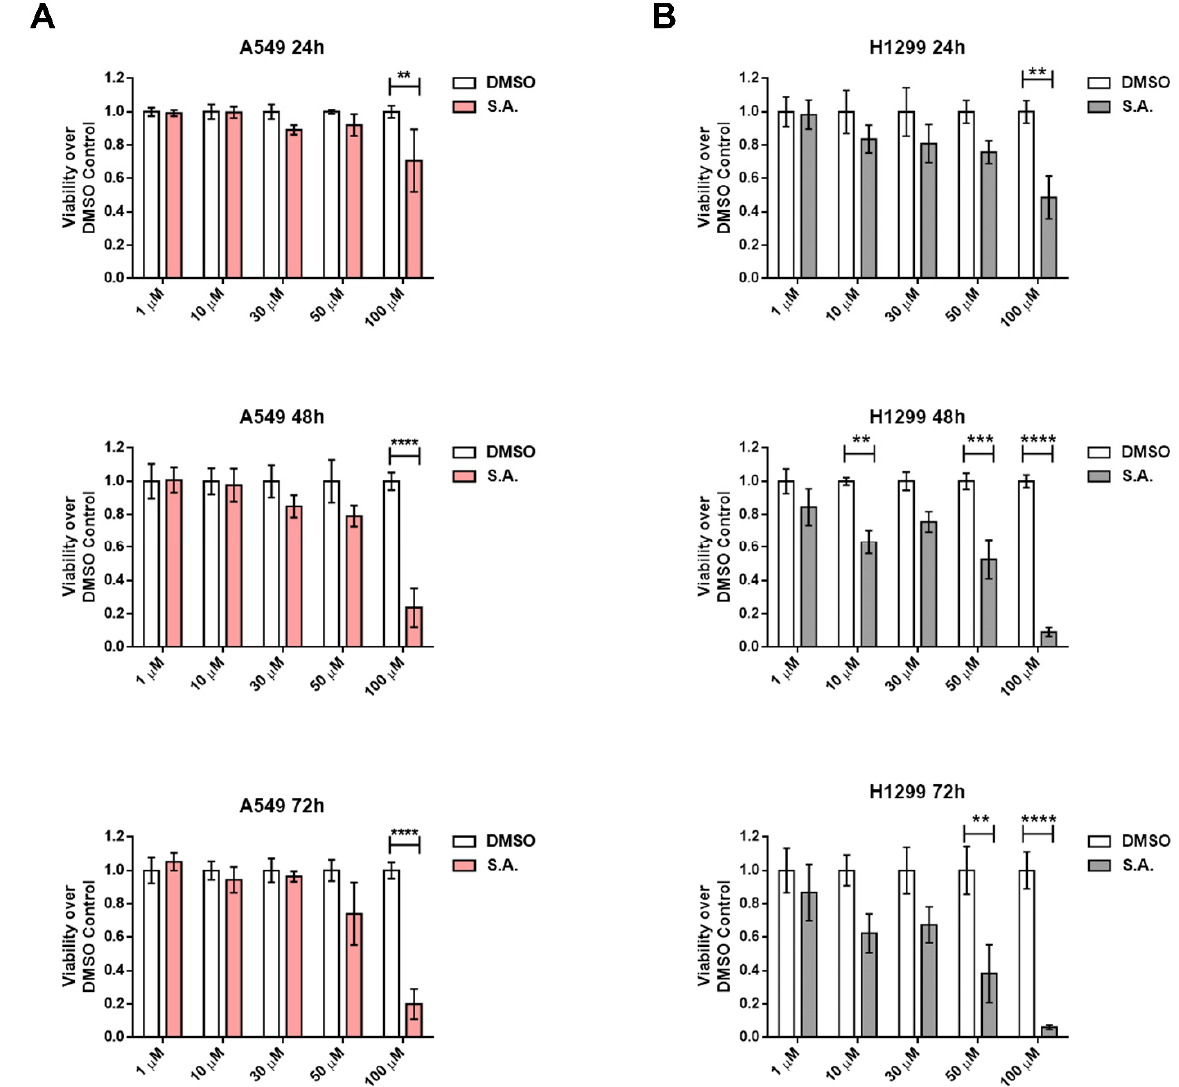
Figure 2. Sterculic acid induces cell death in a dose-time dependent manner in lung cancer cells cultured in serum-free medium. Cell viability after SA treatment (1–100 µM) was measured by MTS method. ( A ) Cell viability over DMSO control of A549 cells. White bars correspond to cells treated with vehicle (DMSO), while pink bars correspond to cells treated with SA (1–100 µM). ( B ) Cell viability over DMSO control of H1299 cells. White bars correspond to cells treated vehicle (DMSO) while grey bars correspond to cells treated with SA (1–100 µM). Data represented mean ± SEM of 48-well plates of at least three different experiments. ** p < 0.01, *** p < 0.001, **** p < 0.0001.